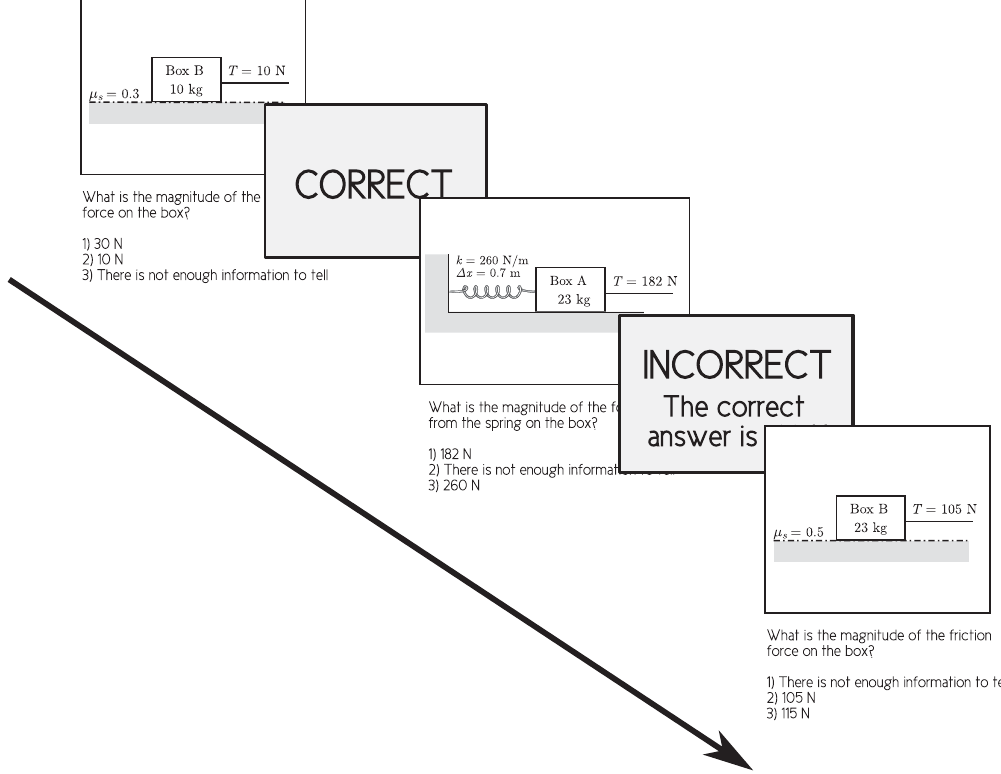
FIG. 4. Examples of the flow of questions posed in the reflexive training condition. Students received 10 of each of the three question types (Box A, B, and (C) in randomized order with the values of the numbers changed on each